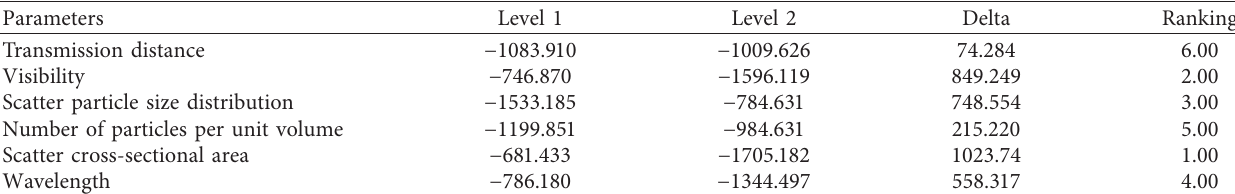
Table 9: Analysis result and importance